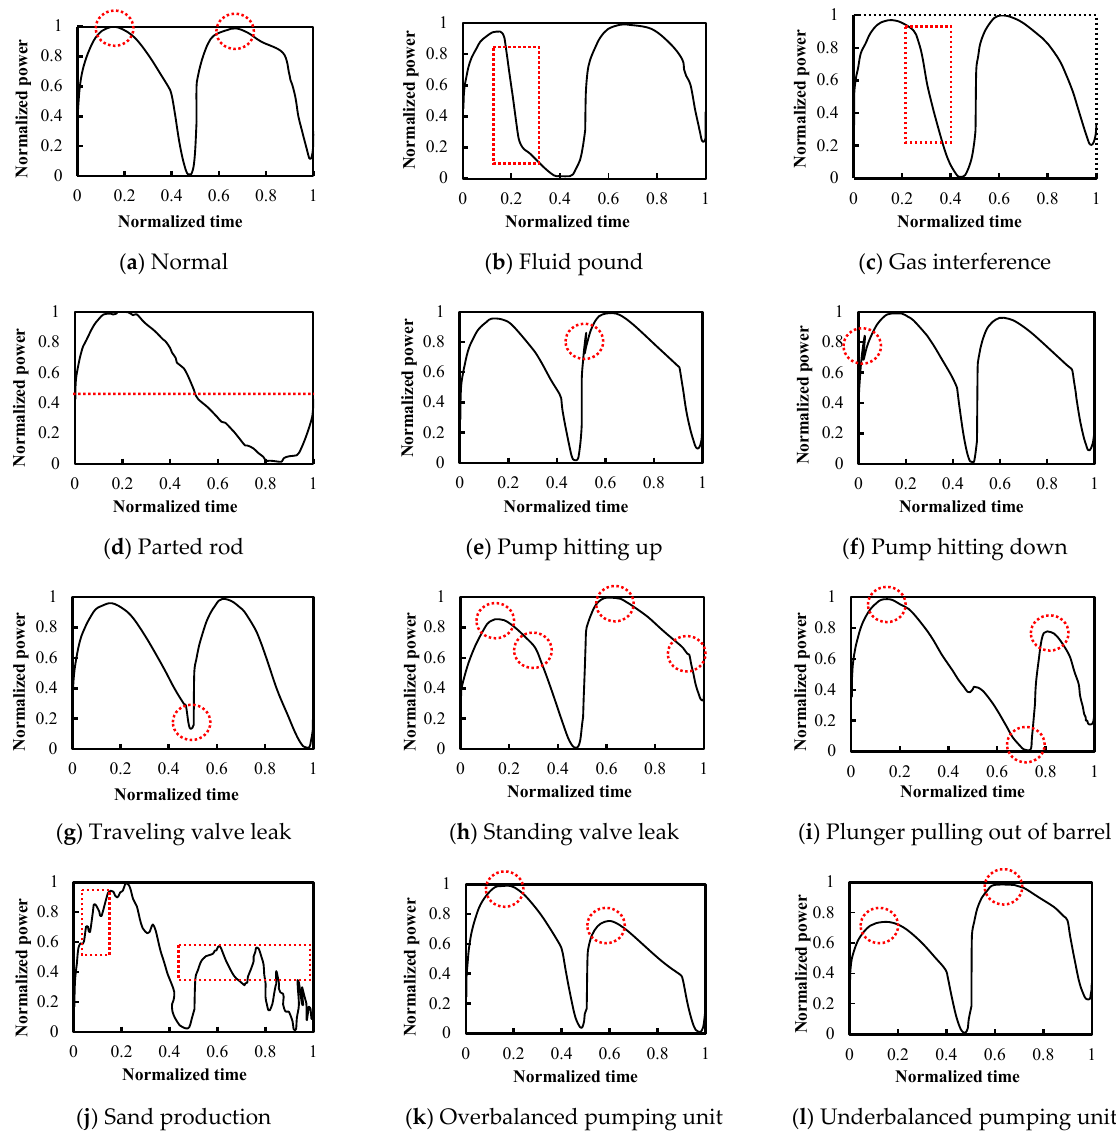
Figure 4. Electric power diagram atlas of variable torque pumping unit well.